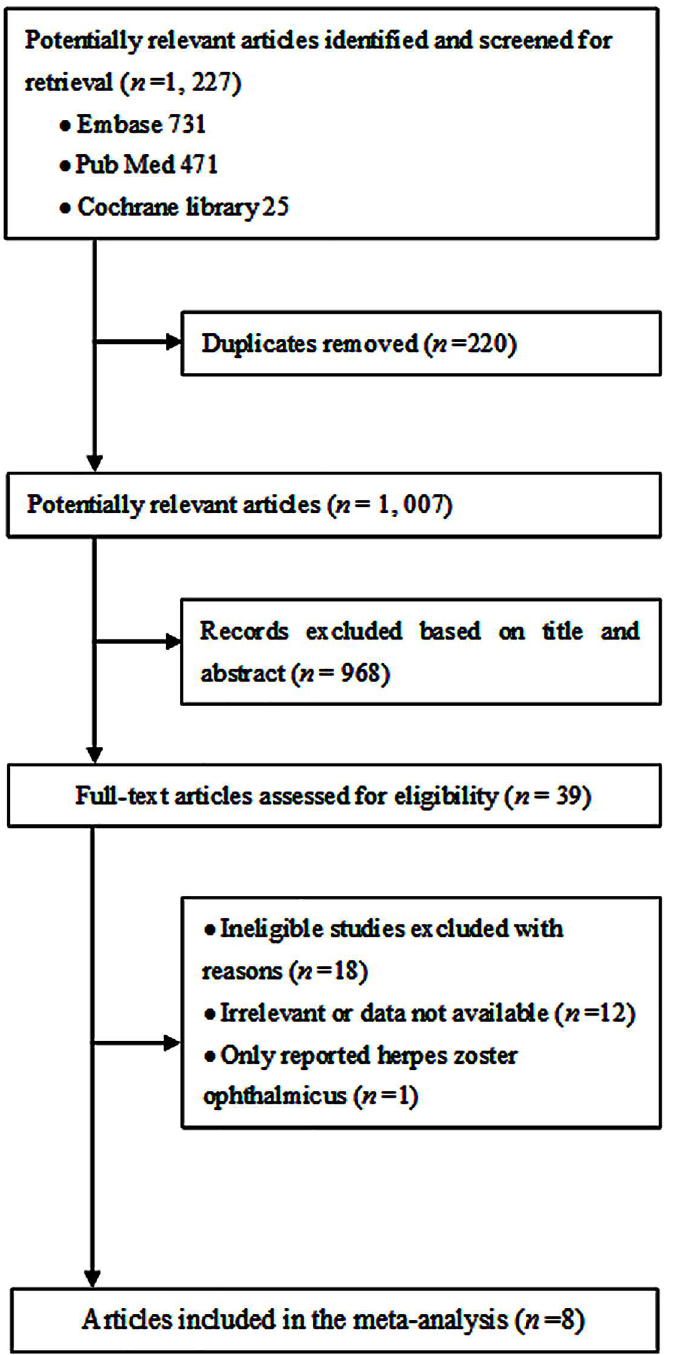
Fig 1. Flow diagram of the search result for the meta-analysis. The figure shows detailed information in the process of search, review, exclusionand inclusionof the potential